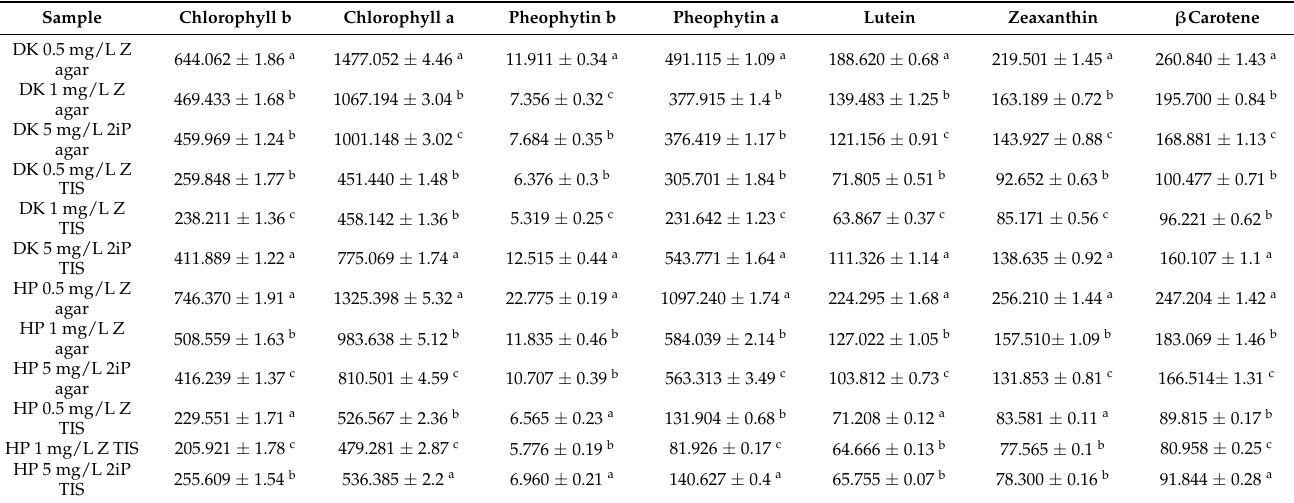
Table 2. The content of individual carotenoid and chlorophyll compounds in the shoot extracts of the two highbush blueberry varieties, for both types of culture systems and three variations of growth regulators, using HPLC-MS and expressed as µ g/g